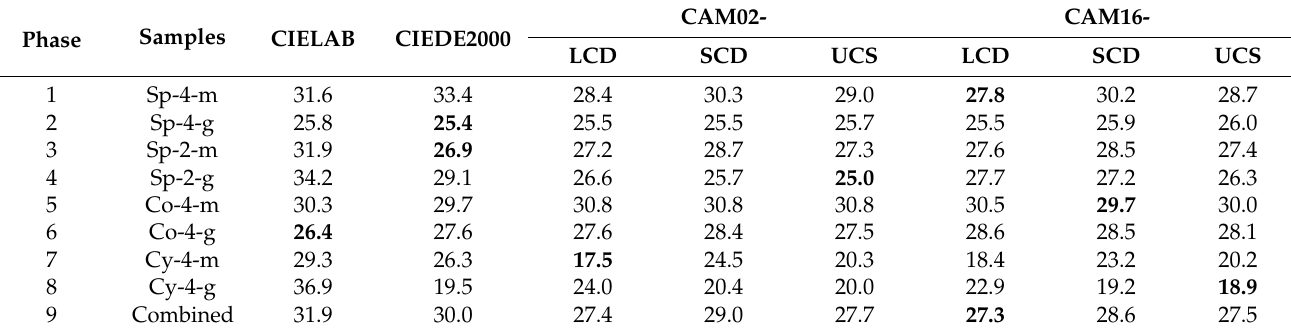
Table 3. STRESS values [25] for eight color-difference formulas considering each of the nine phases (Table 1) in the visual experiments with 3D objects reported in [24]. The numbers in bold indicate the best color-difference formula (lowest STRESS value) for each